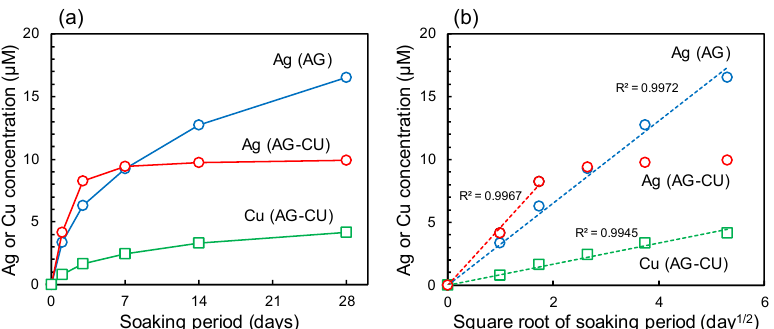
Figure 4. Ag and Cu ion release behavior from samples in PBS. ( a ) Accumulated-released amounts of Ag or Cu vs. soaking period and ( b ) accumulated-released amounts of Ag or Cu vs. square root of soaking period.